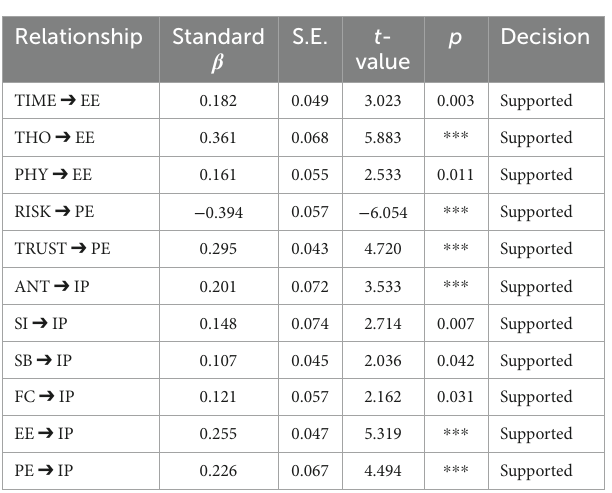
TABLE 8 The maximum likelihood estimation of standard path